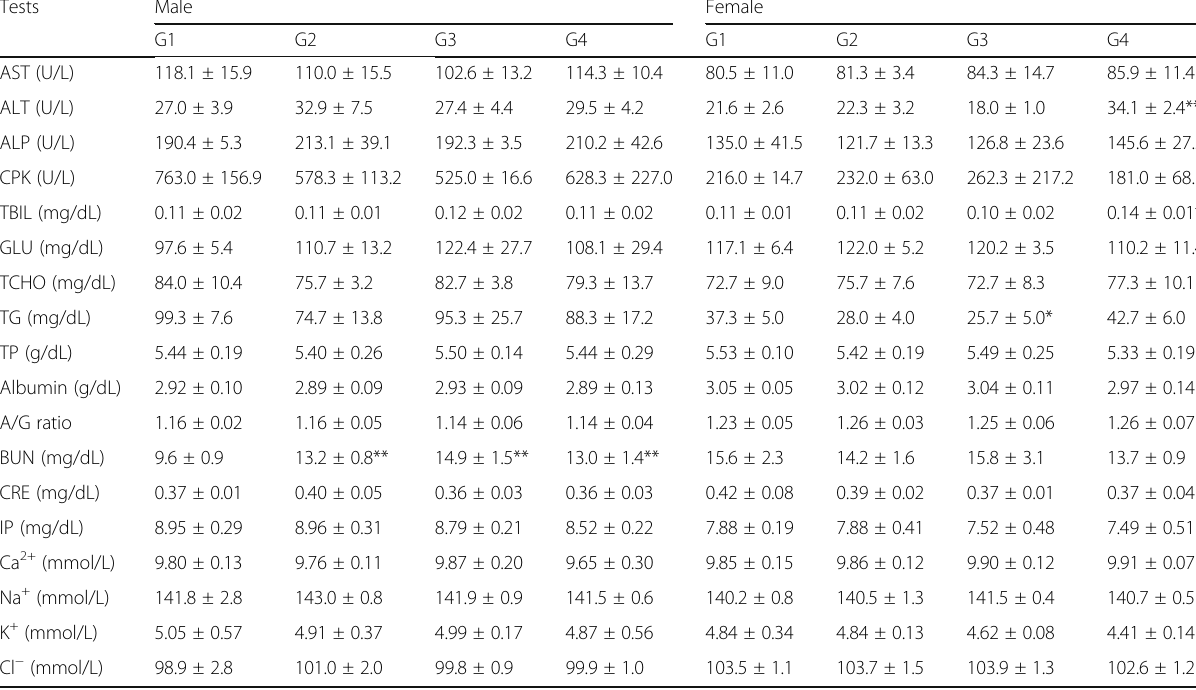
Table 4 Effect of oral administration of OE on serum biochemical